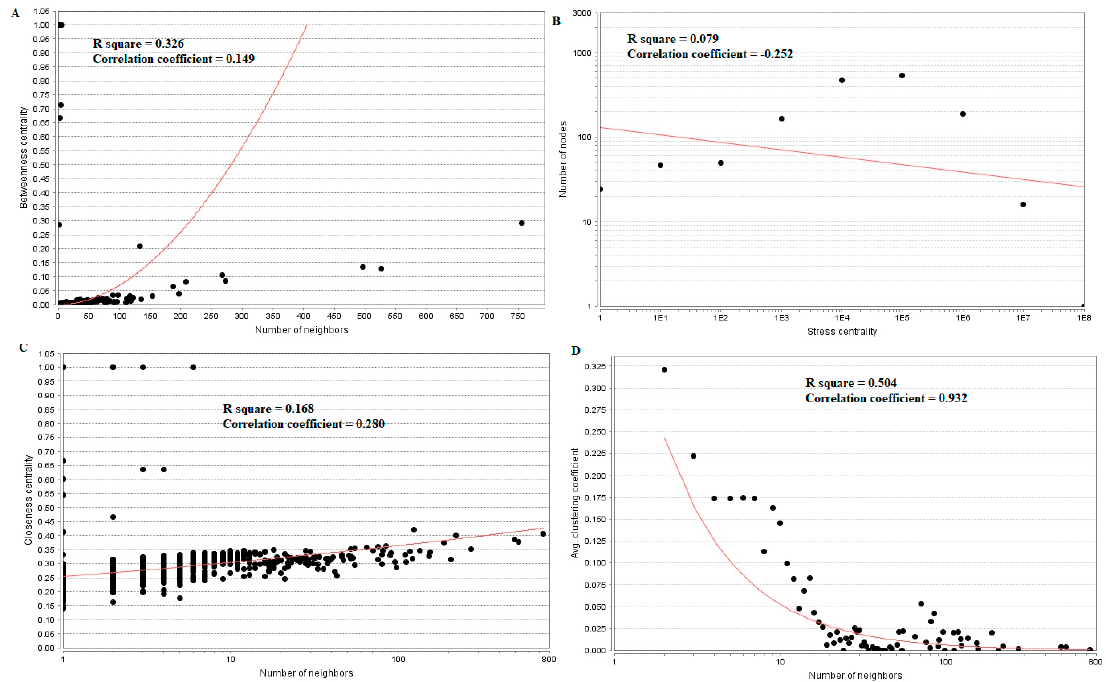
Figure 9. Regression diagrams for Down-regulated genes (( A ) Betweenness centrality; ( B ) Stress centrality; ( C ) Closeness centrality; ( D ) Clustering coefficient). The red straight lines and the red curve lines: regression lines.